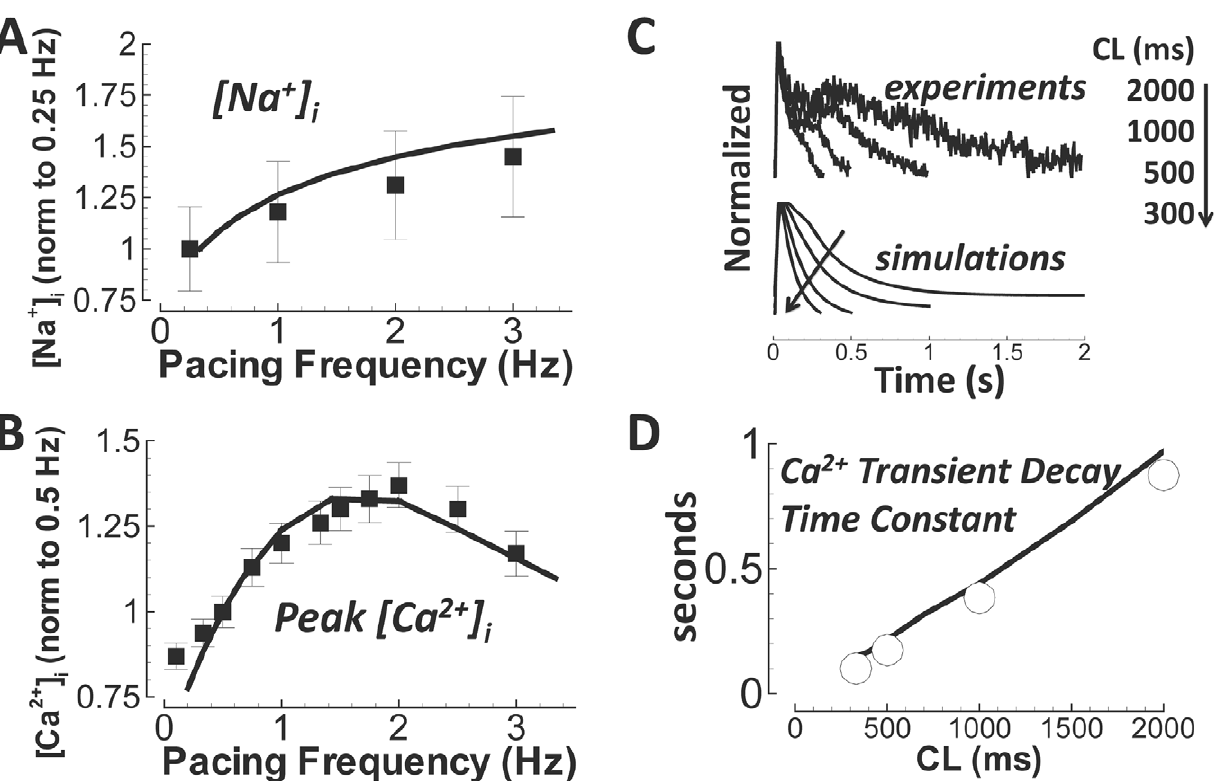
Figure 12. Rate dependence of intracellular ion concentrations. Simulation results are solid lines. A) [Na + ] i versus pacing frequency (normalized to 0.25 Hz). Experiments are from nonfailing myocytes (Pieske et al.[57], black squares). B) Peak Ca 2 + transient (normalized to 0.5 Hz). Experiments are from nonfailing myocytes (Schmidt et al.[76], black squares). C) Ca 2 + transients from experiments (Fura-2-AM) and simulations. Results are normalized to illustrate the time course of decay. The arrow indicates pacing CL changes. D) Frequency dependent acceleration of relaxation. Undiseased human experimental data are white circles. Simulations are the black line.